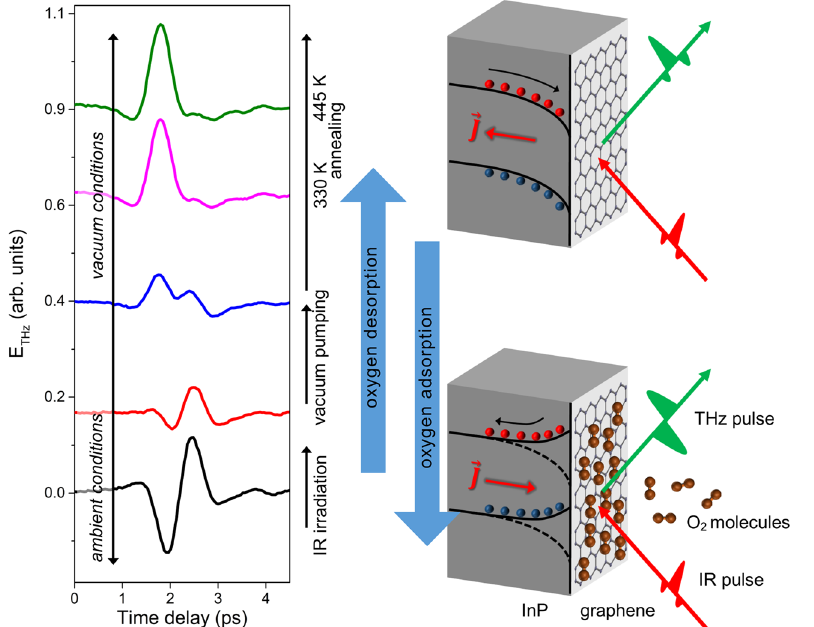
Figure 1. THz emission waveforms from Graphene/InP measured by TPTEM. Initially, when O 2 molecules are adsorbed in graphene, modification in the surface depletion field causes the photoexcited current to move towards the surface of InP, generating THz radiation with waveform containing a dip at ~2 ps and a peak at ~2.5 ps. Desorption of O 2 by IR irradiation and/or vacuum pumping causes both features to gradually vanish, followed by the appearance of a positive peak at ~2 ps. Subsequent annealing removes more adsorbates, and the THz emission from graphene/InP becomes very similar to the emission from bare InP, signifying that the photoexcited current flows towards the substrate. Exposure of sample to air allows O 2 to be adsorbed on graphene, which reverts the THz emission back to the initially observed